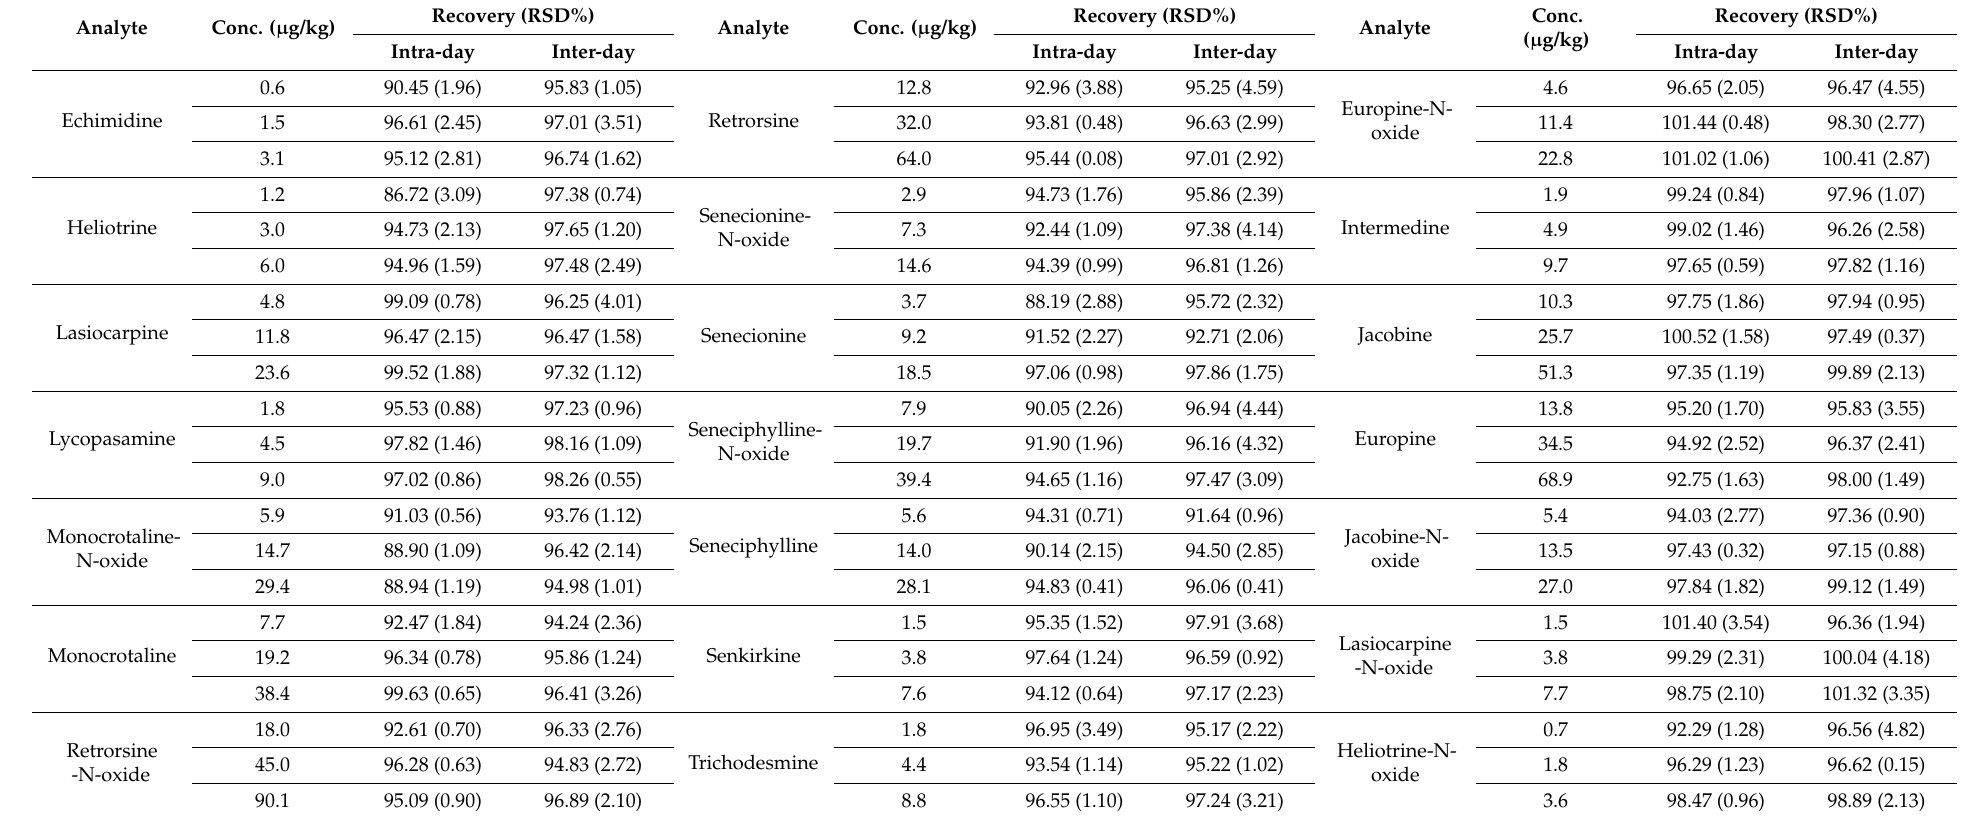
Table 3. Accuracy and precision (n = 3) for the developed LC-MS/MS method in tea